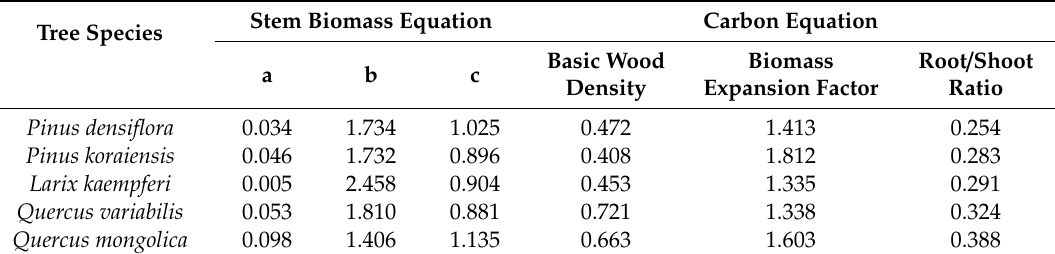
Table 1. Coe ffi cients for stem volume equations and carbon emission factors by tree species, developed by the National Institute for Forest Science [36]. The coe ffi cients for each tree species were applied to both Cool and other